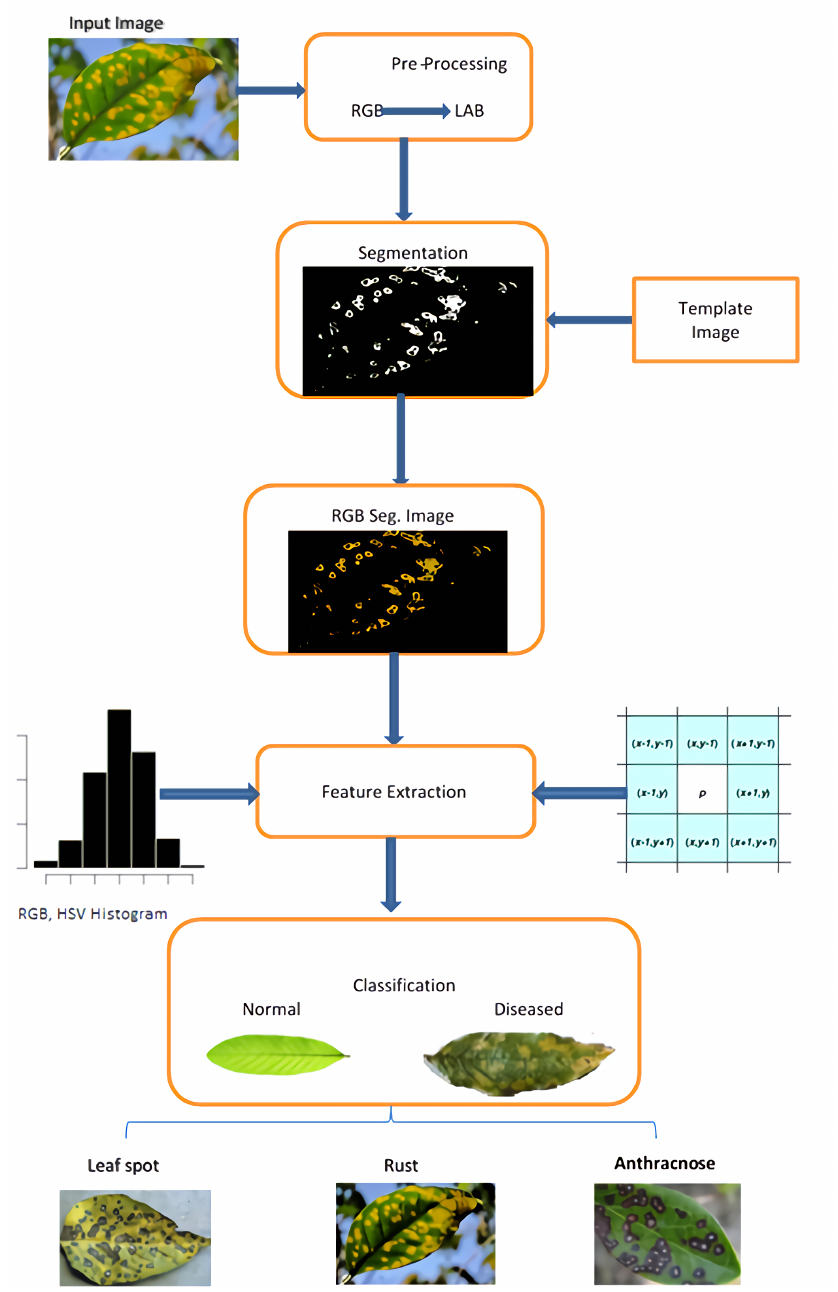
Figure 1. Workflow of Guava disease classification